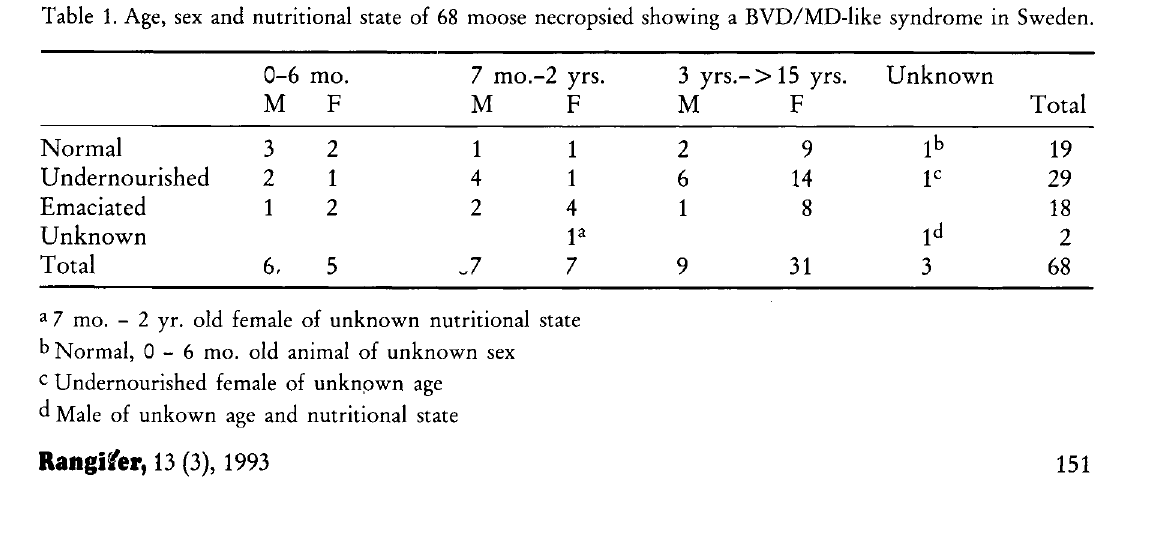
Table 1. Age, sex and nutritional state of 68 moose necropsied showing a BVD/MD-like syndrome in Sweden. 0-6